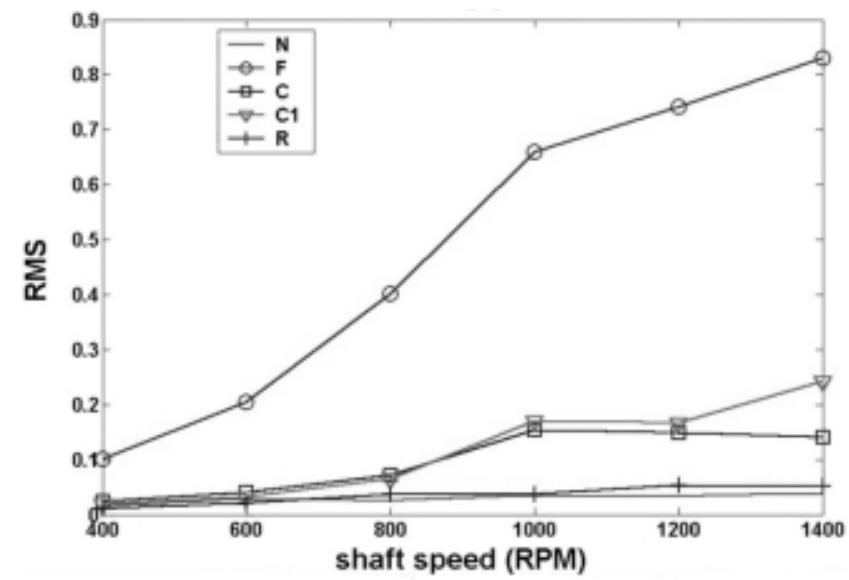
Fig. 4. Kurtosis of the velocity signal as a function of the rotating shaft speed, load 3.